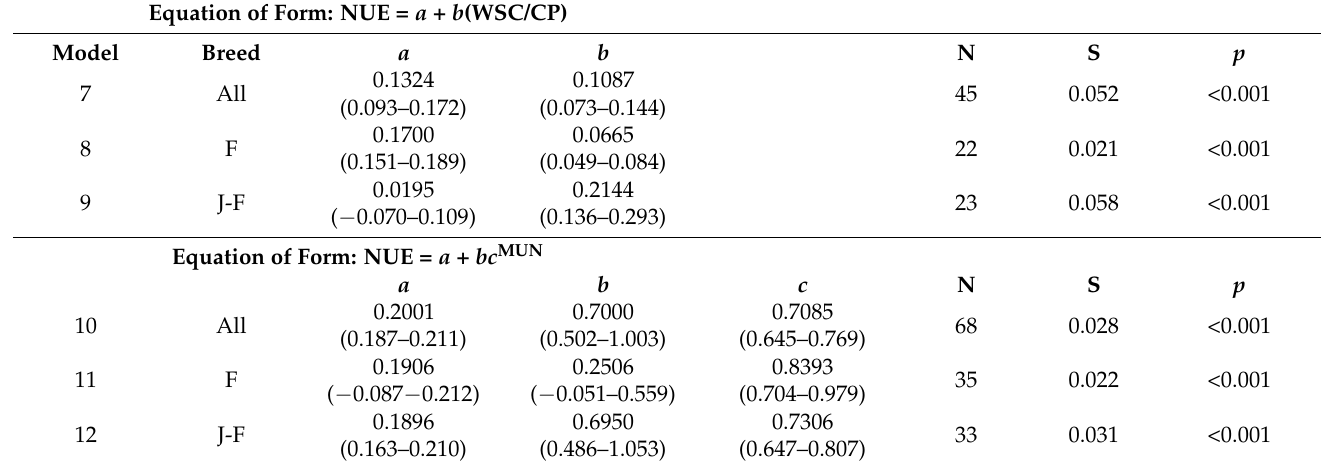
Table 6. Models (coefficients (95% CI)) relating NUE of ryegrass-fed Friesian and Jersey × Friesian cows to the dietary parameter WSC/CP and animal-based parameter MUN. Models are given for all the available data and each breed separately. S is the standard error of the